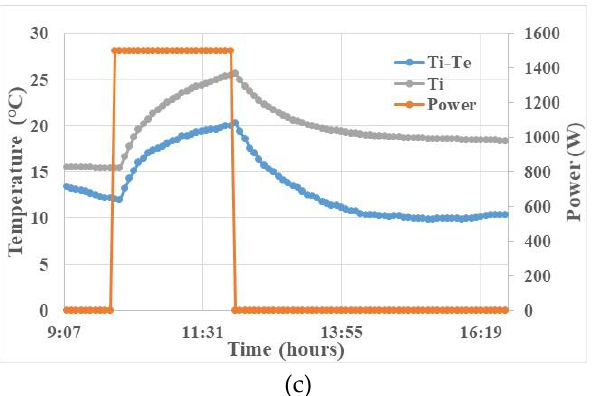
Figure 2 . Variation of indoor and outdoor temperature while heating: ( a ) 4 hours heating at 1500 W; ( b ) 4 hours heating at 900 W; ( c ) 2 hours heating at 1500 W.